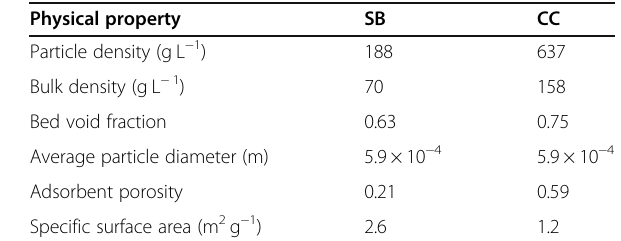
Transport parameters